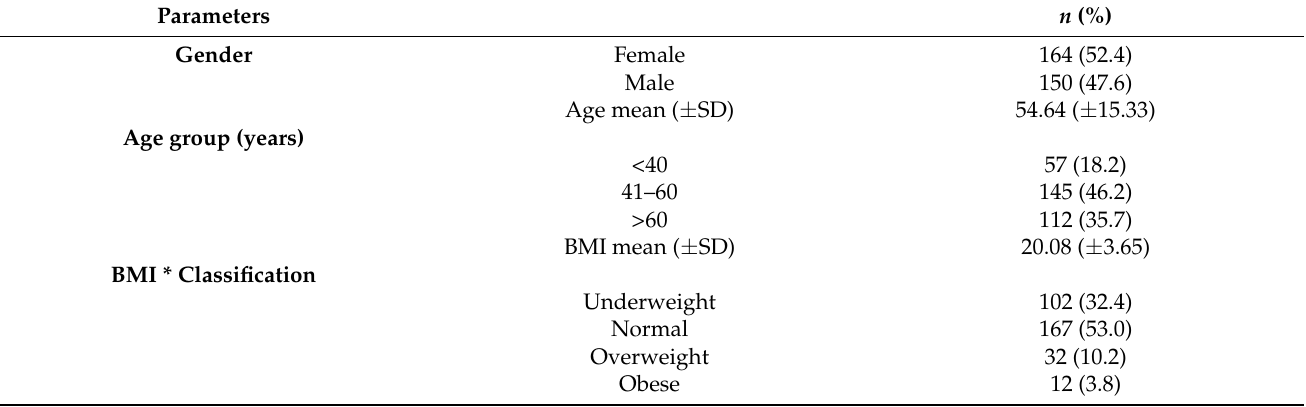
Table 1. Demographic variables Clinical Characteristics ( n =